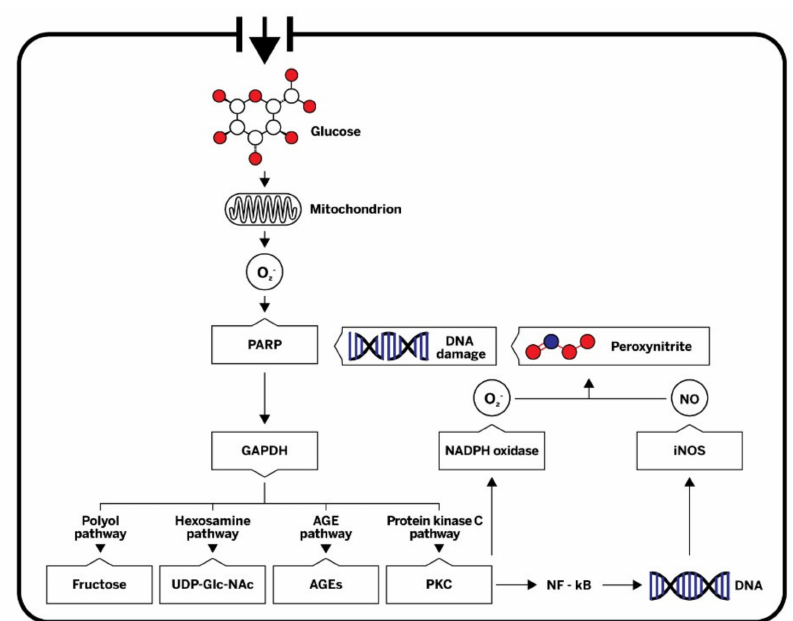
Figure 2. A simplified scheme of mechanisms by which hyperglycemia induces metabolic derange- ment in endothelial cells. Hyperglycemia-induced overproduction of mitochondrial superoxide activates four major pathways of hyperglycemic damage by inhibiting GAPDH. PKC and NF- κ B are also activated, affecting nitric oxide (NO) production and inflammatory response. NO can react with superoxide, leading to the formation of the highly reactive peroxynitrite, which in turn damages DNA. Single DNA strand breaks stimulate the activation of PARP, thereby resulting in decreased activity of GAPDH. O 2 − , superoxide; PARP, poly (ADP-ribose) polymerase; GAPDH, glyceraldehyde- 3-phosphate dehydrogenase; UDP-GlcNAc, uridine diphosphate N-acetylglucosamine; AEGs, ad- vanced glycation end-products; PKC, protein kinase C; NADPH, nicotinamide adenine dinucleotide phosphate; DNA, deoxyribonucleic acid, NF- κ B, nuclear factor kappa B; iNOS, inducible nitric oxide synthase; NO, nitric